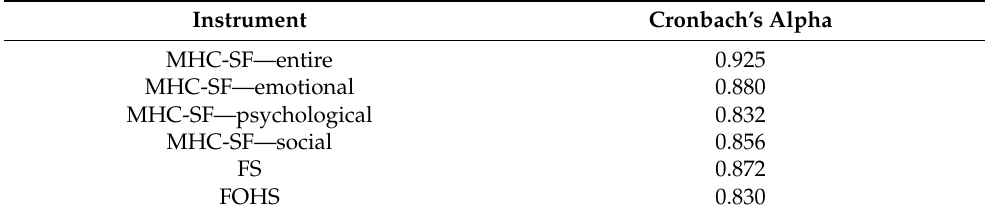
Table 2. Cronbach’s alpha coefficients for the three instruments.